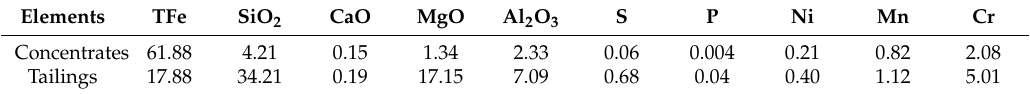
Figure 17. SEM-EDS image of magnetic concentrates obtained from the nickel slag under the optimal conditions.